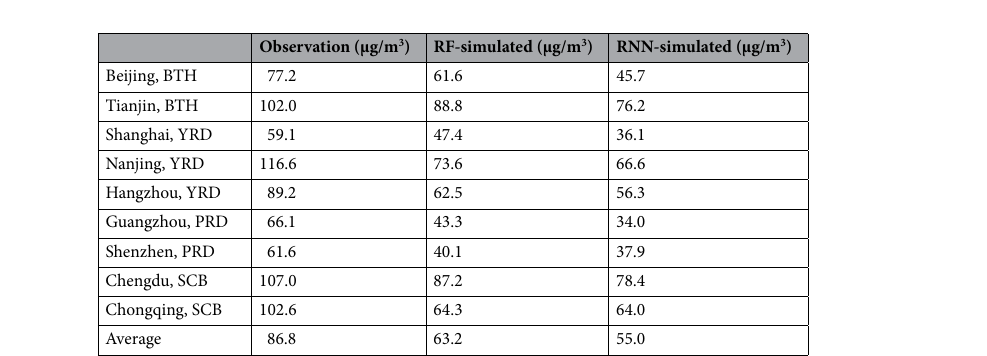
Table 3. Monthly average observed and predicted PM 10 in January of 2019: Scenario